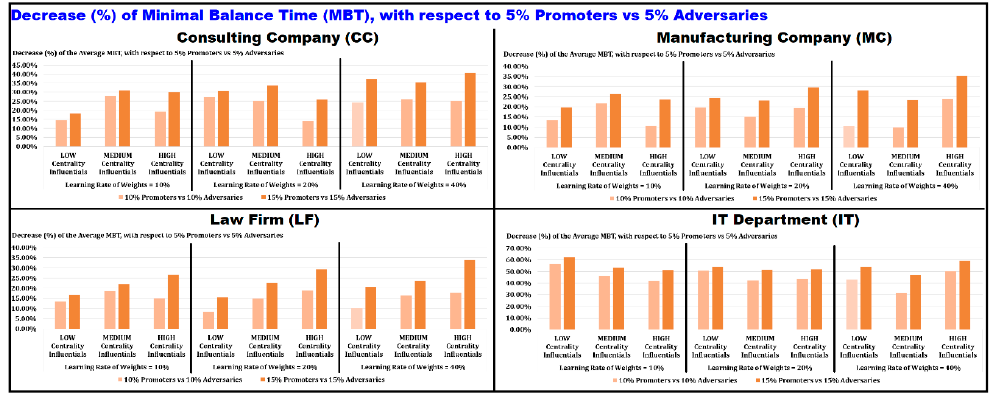
Figure 8. Relative Decrease (%) of Minimal Balance (blue lines in Figure 5) for the selected values of centrality and learning rate (Table 3). The decrease of Minimal Balance when promoters and adversaries increase from 5% to 10% is indicated in the left column. The right column (darker) shows the decrease when promoters and adversaries increase from 5% to 15%.